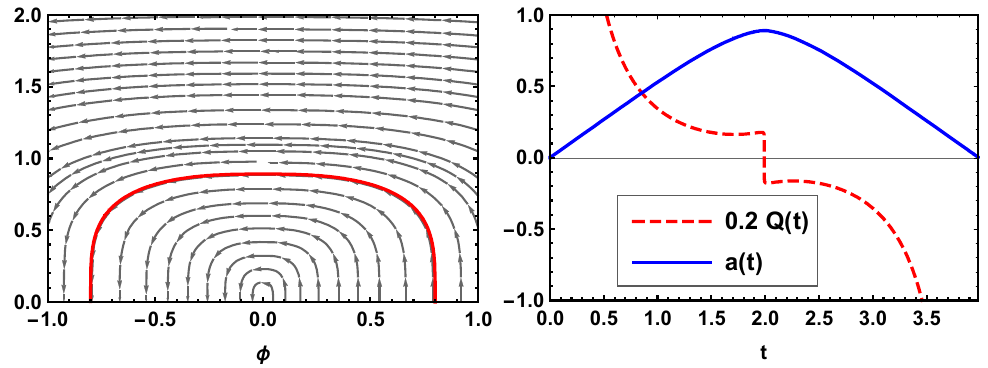
Figure 1. On the left-hand side, we see the phase portrait of system (32), for the dust case ( w = 0), with V 0 = k = 1, and the red line represents the particular solution for which φ ( 0 ) = 0.8 and a ( 0 ) = 0.001, as an example. On the right-hand side, we see the behavior of the scale factor (thick line) versus the quantum potential (33) (dashed line), both being evaluated for the particular solution highlighted in the phase